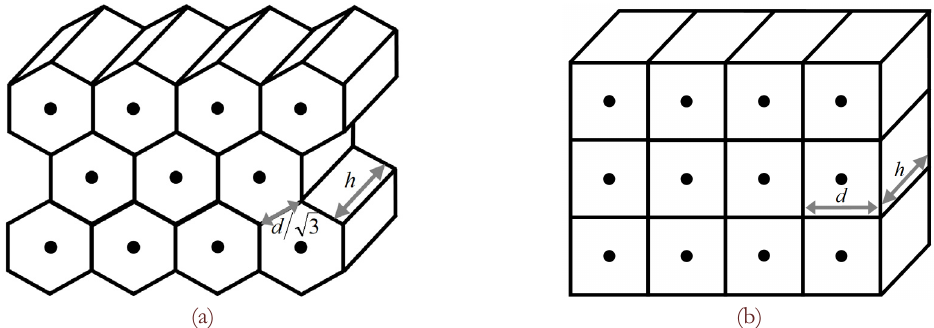
Figure 4: Examples of regular packing of elements in 2D problem statement: close packing (a) and square packing (b).